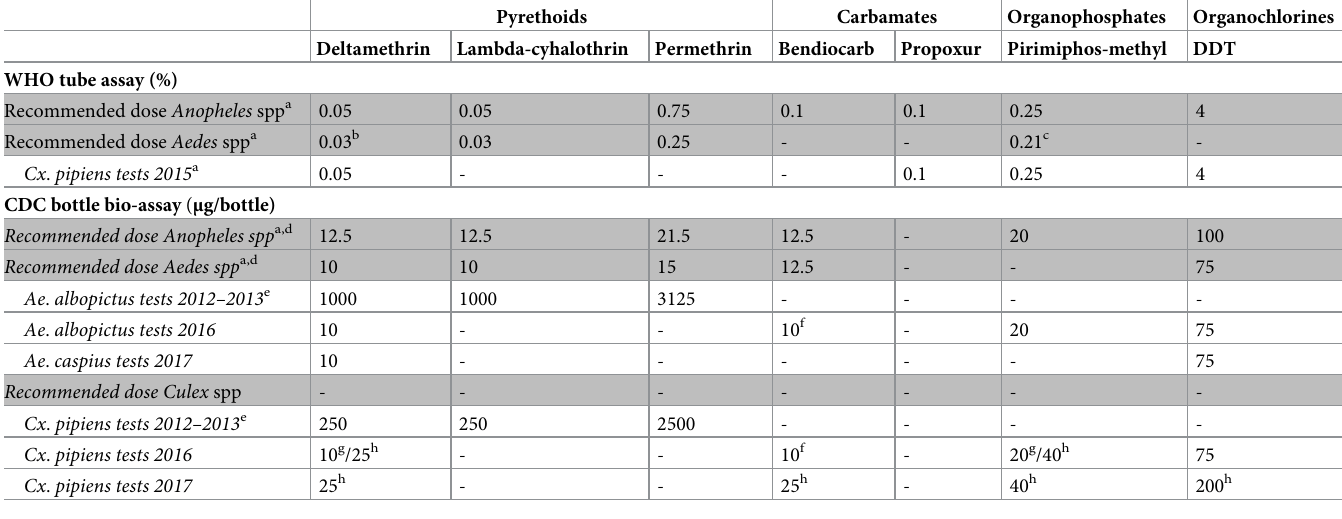
Table 1. Available information on the discriminating bioassay concentrations of insecticides for determining susceptibility of adult anopheline and culicine mos- quitoes using WHO and CDC insecticide susceptibility tests for the insecticides used in our studies. Pyrethoids